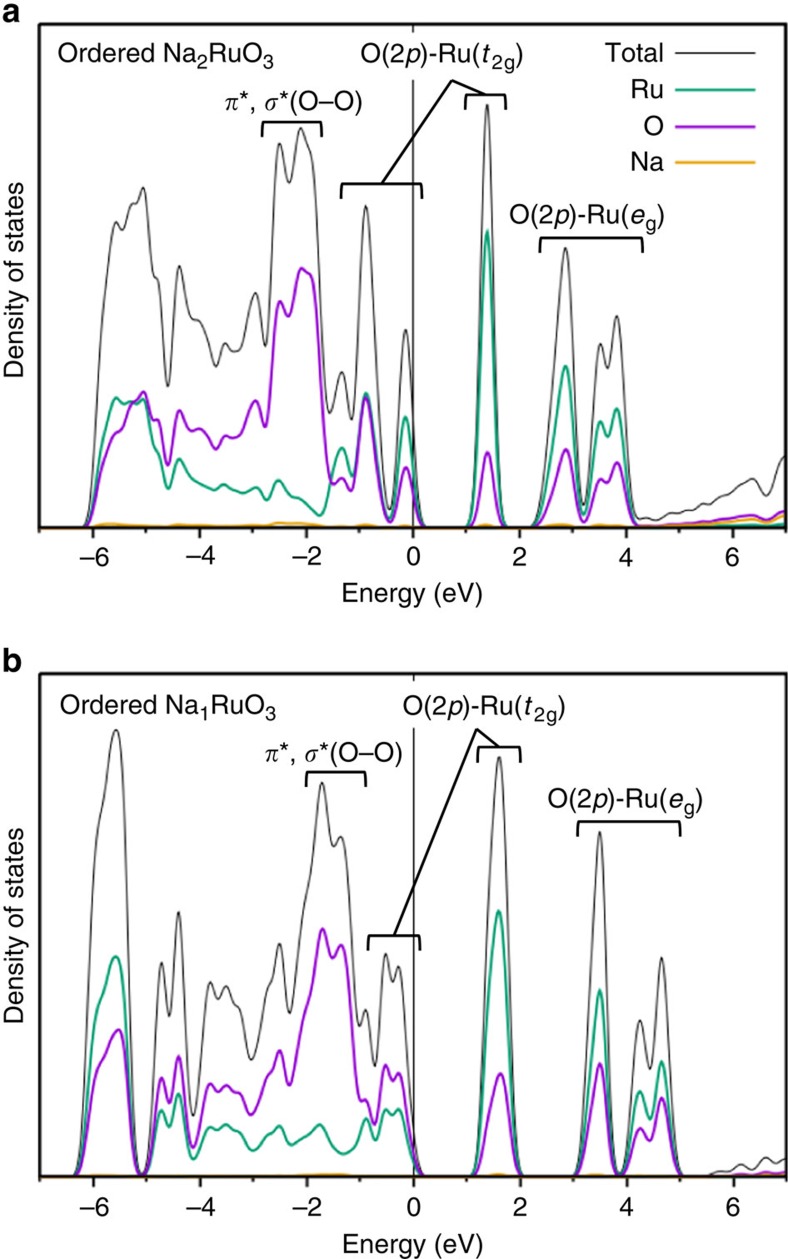
Calculated electronic structure of ordered Na2RuO3 upon charge.Calculated density of states (DOS) for ordered (a) O3-Na2RuO3 and (b) ilmenite-type Na1RuO3.